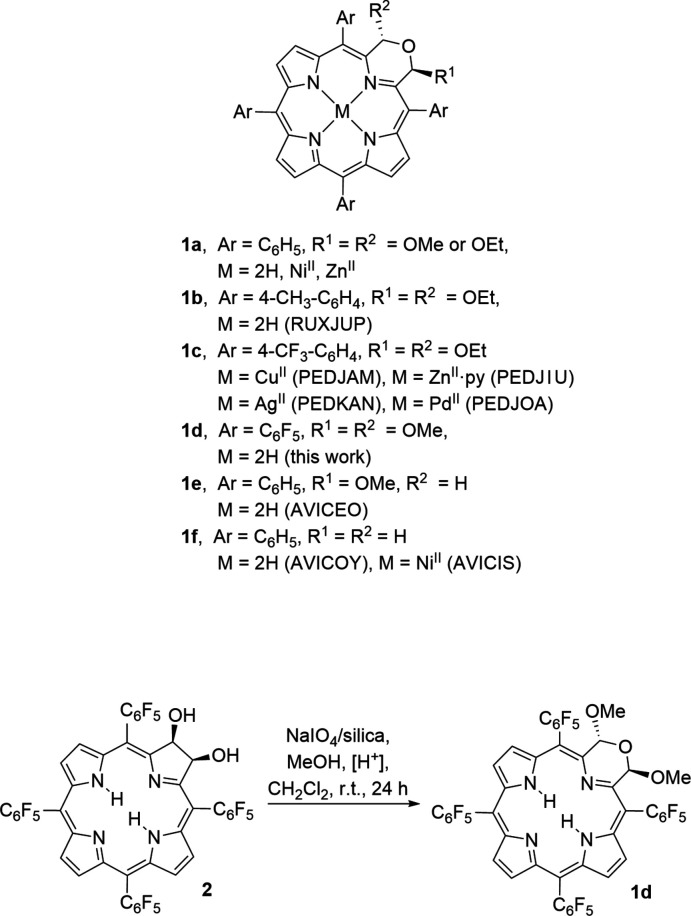
Structures of select morpholino­chlorins